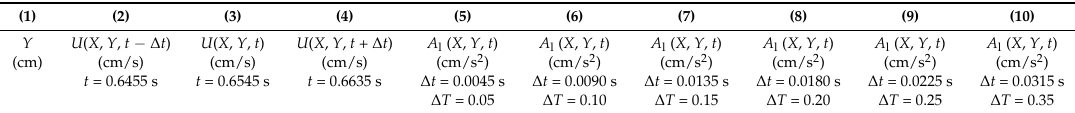
Table A1. A list of velocity data at different times and calculation of the local acceleration A l with six different time intervals. Note that the partially depth-averaged values of the local acceleration, A l,da and their relative deviations, D r , are addressed at the bottom of the